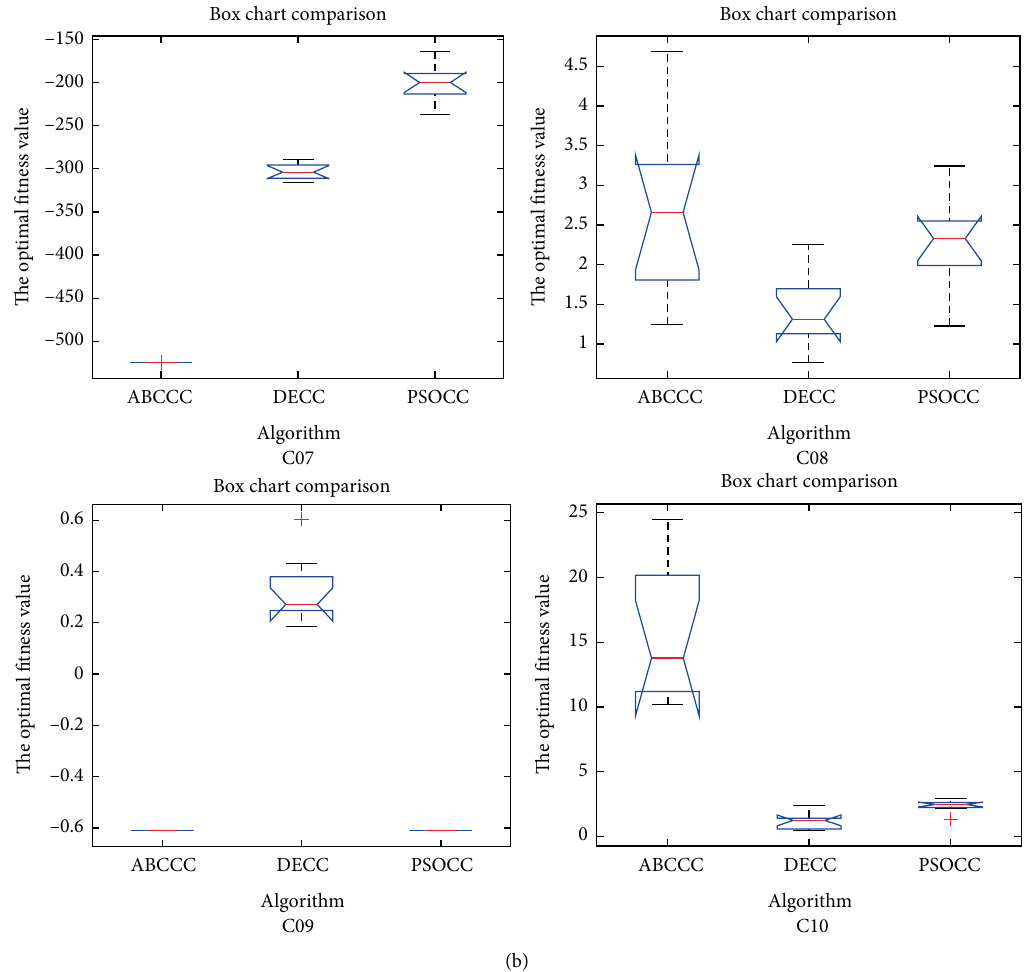
Figure 3: Box plot comparison results of the three algorithms (10-